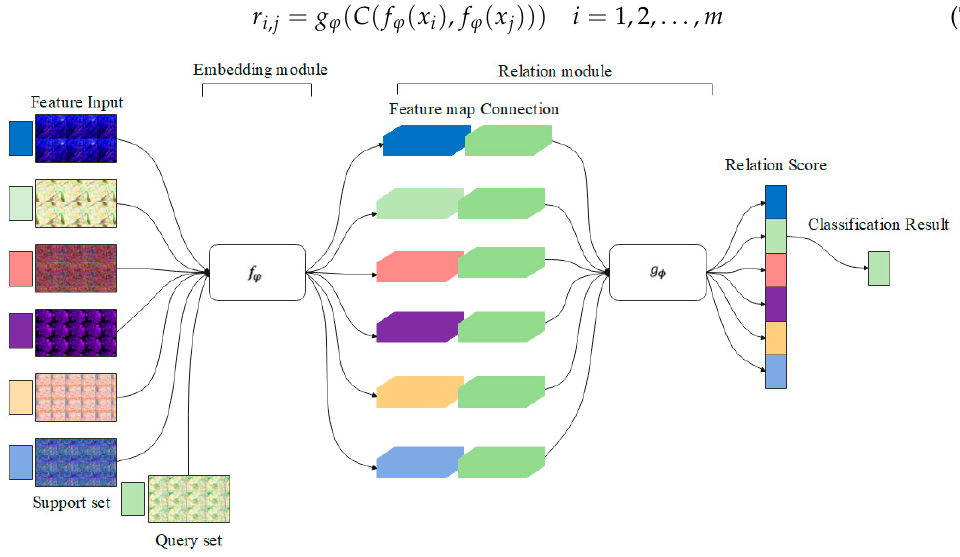
Figure 2. The structure of relation network.